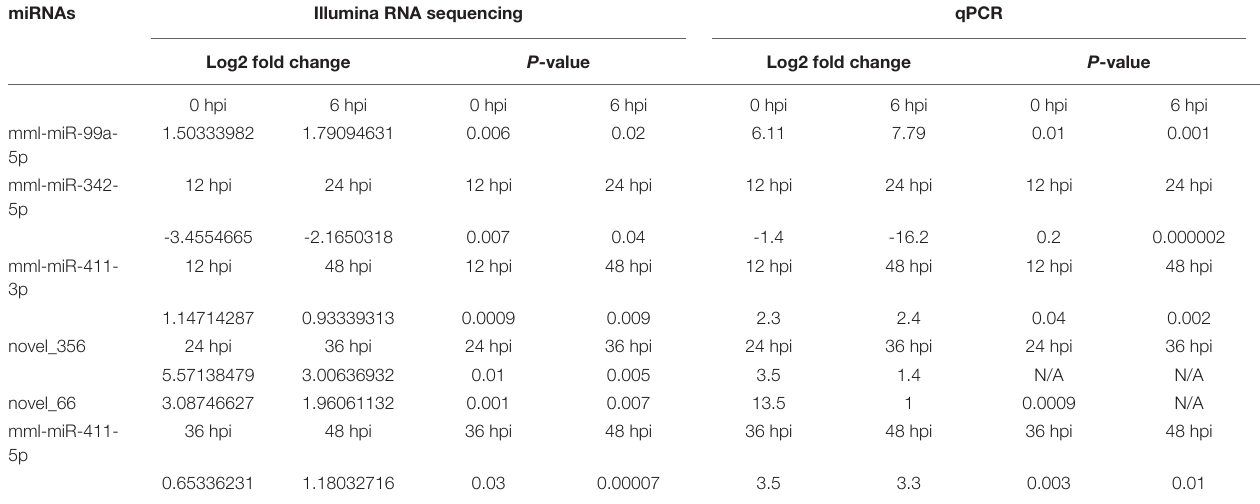
FIGURE 9 | (A–F) Expression levels of the common differentially expressed (DE) microRNAs (miRNAs) at different time points of bovine rotavirus (BRV) infection. The differences in expression were determined using the 2 - (cid:49)(cid:49) CT method and with unpaired, two-tailed Student’s t -test for grouped data. All experiments were performed in triplicate ( n = 3). U6 was used as an internal reference. Data represent the mean ± SD ( error bar ). Significant difference thresholds: log2(fold change) > 2 and FDR-adjusted p < 0.05. TABLE 2 | The expression levels (log2 fold changes) of common DE miRNAs, by Illumina sequencing and qPCR at the different time points of BRV infection. miRNAs Illumina RNA sequencing